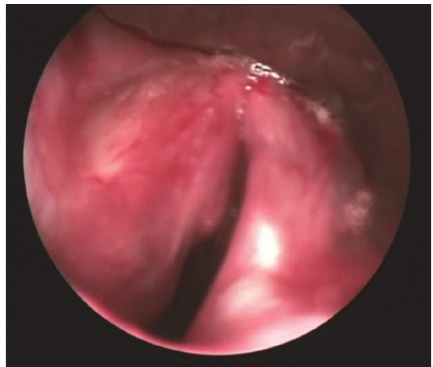
Figure 4: View of the glottis and superior aspect of the subglottic